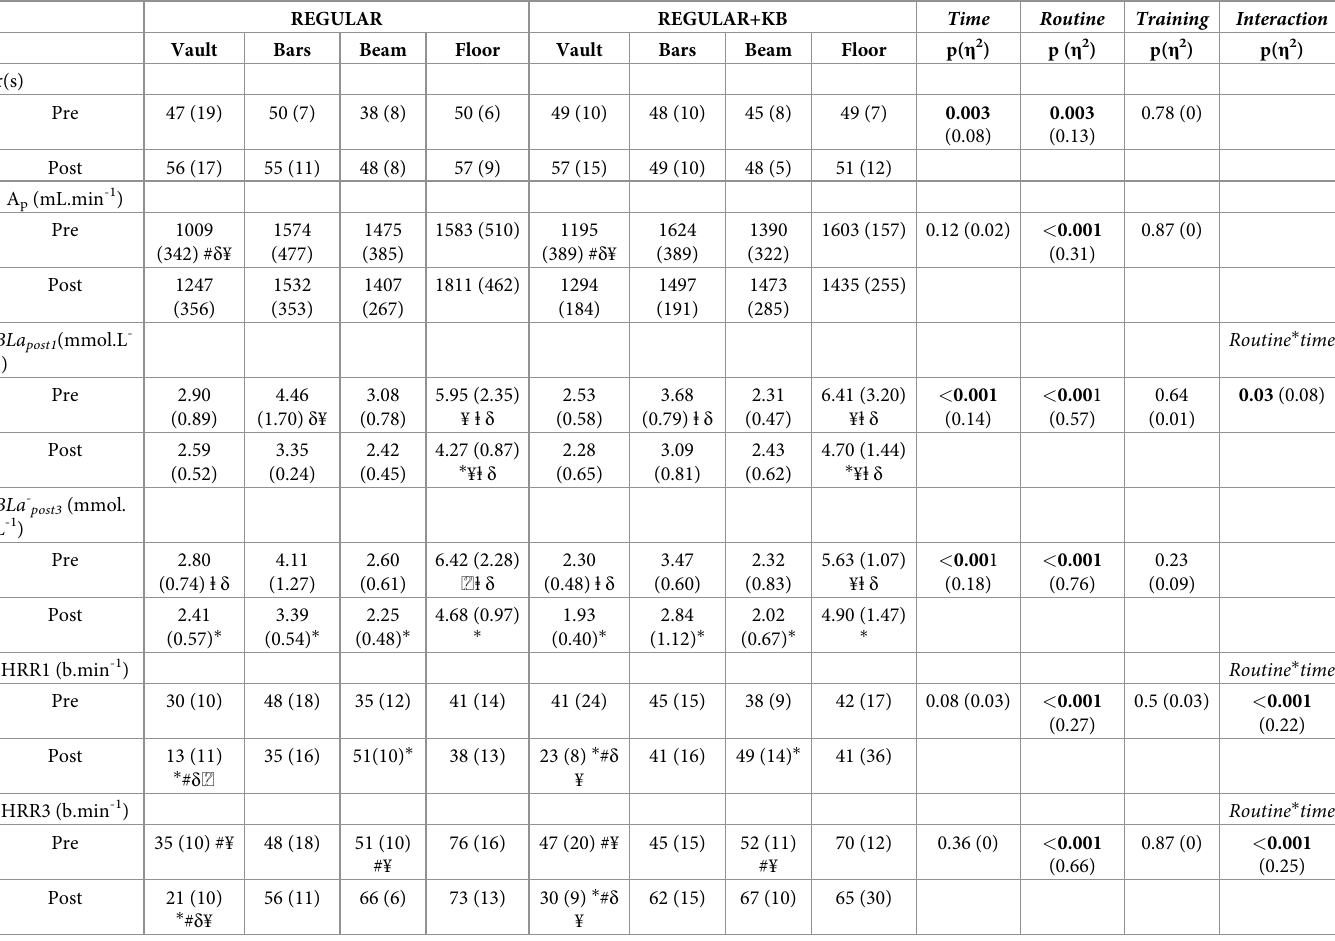
Table 3. Effects of exercise training protocols on oxygen uptake and blood lactate after the artistic gymnastics